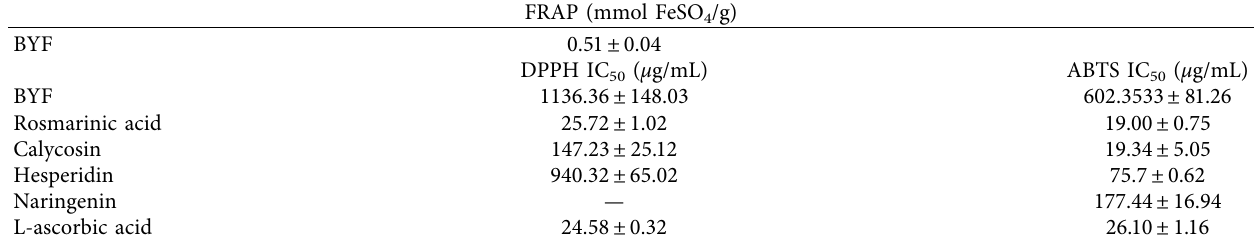
Table 2: ABTS radical scavenging activity, DPPH radical scavenging activity, and ferric-reducing antioxidant power (FRAP) of